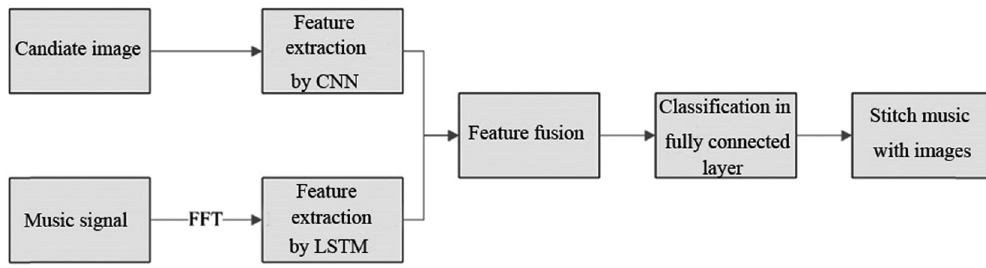
Figure 1: Deep learning - based music visualization